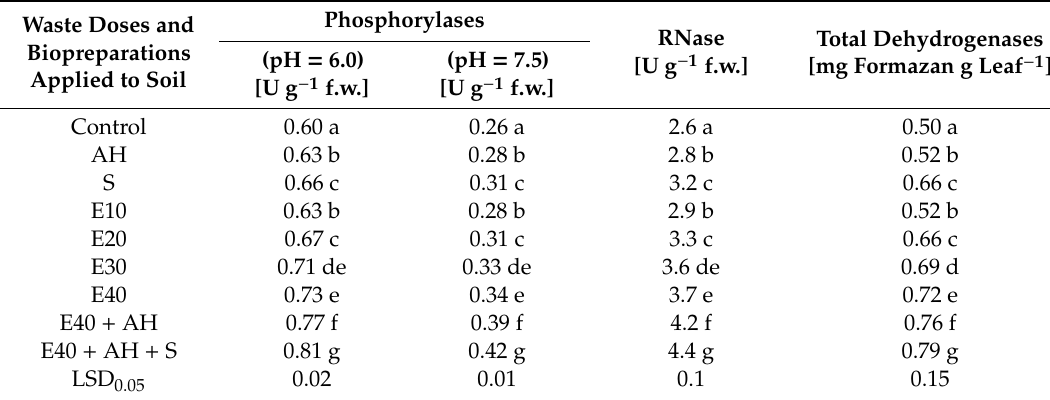
Table 1. Activities of the selected enzymes in leaves of Jerusalem artichoke plants grown in a field and fertilized with liquid non-centrifuged waste from corn grain digestion to methane (E10, 40 m 3 ha − 1 ),